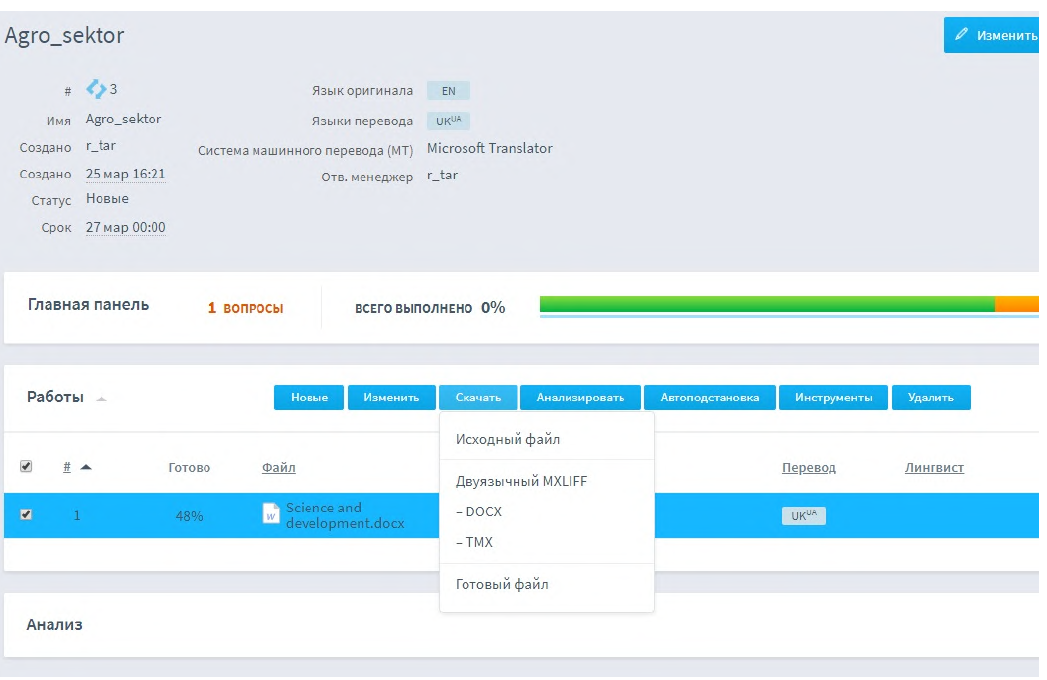
Figure 7: Operations for obtaining translation results.